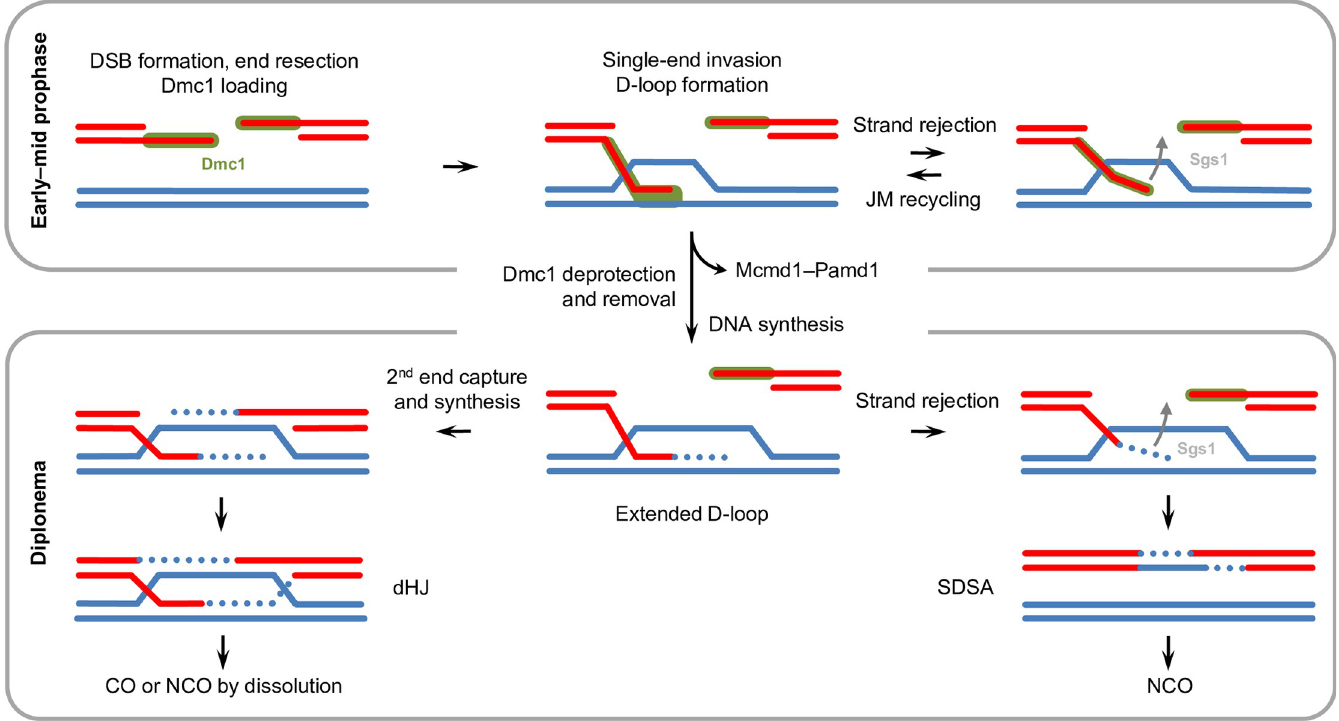
Fig 6. Model of D-loop progression. Single-stranded 3´ overhangs at DSB ends become loaded with Dmc1 (green). One end can invade a DNA molecule to probe for homology and form a Dmc1–heteroduplex strand. Early joint molecules (JMs) will mainly be formed between sister DNA molecules and are unstable. They can reject the invading strand with the help of Sgs1 and then re-use it in subsequent rounds of homology testing. In diplonema, the heteroduplex is stripped of Dmc1, allowing DNA synthesis (dotted line) to begin at the OH-end of the invading strand. This will extend the D-loop. The extended strand can then be displaced, pair with the other end of the DSB, fill the gaps (via synthesis-dependent strand annealing – SDSA), and produce a noncrossover (NCO). Alternatively, the extended D-loop may capture the second DSB end and form a double Holliday junction (dHJ). This intermediate may either become a NCO by dissolution or mature into a crossover (CO). In the absence of Sgs1, early JMs will persist into diplonema and be then transformed into (mainly intersister) COs. In the absence of Mcmd1–Pamd1, early JMs will be immediately converted to extended D-loops and also result primarily in intersister exchange.